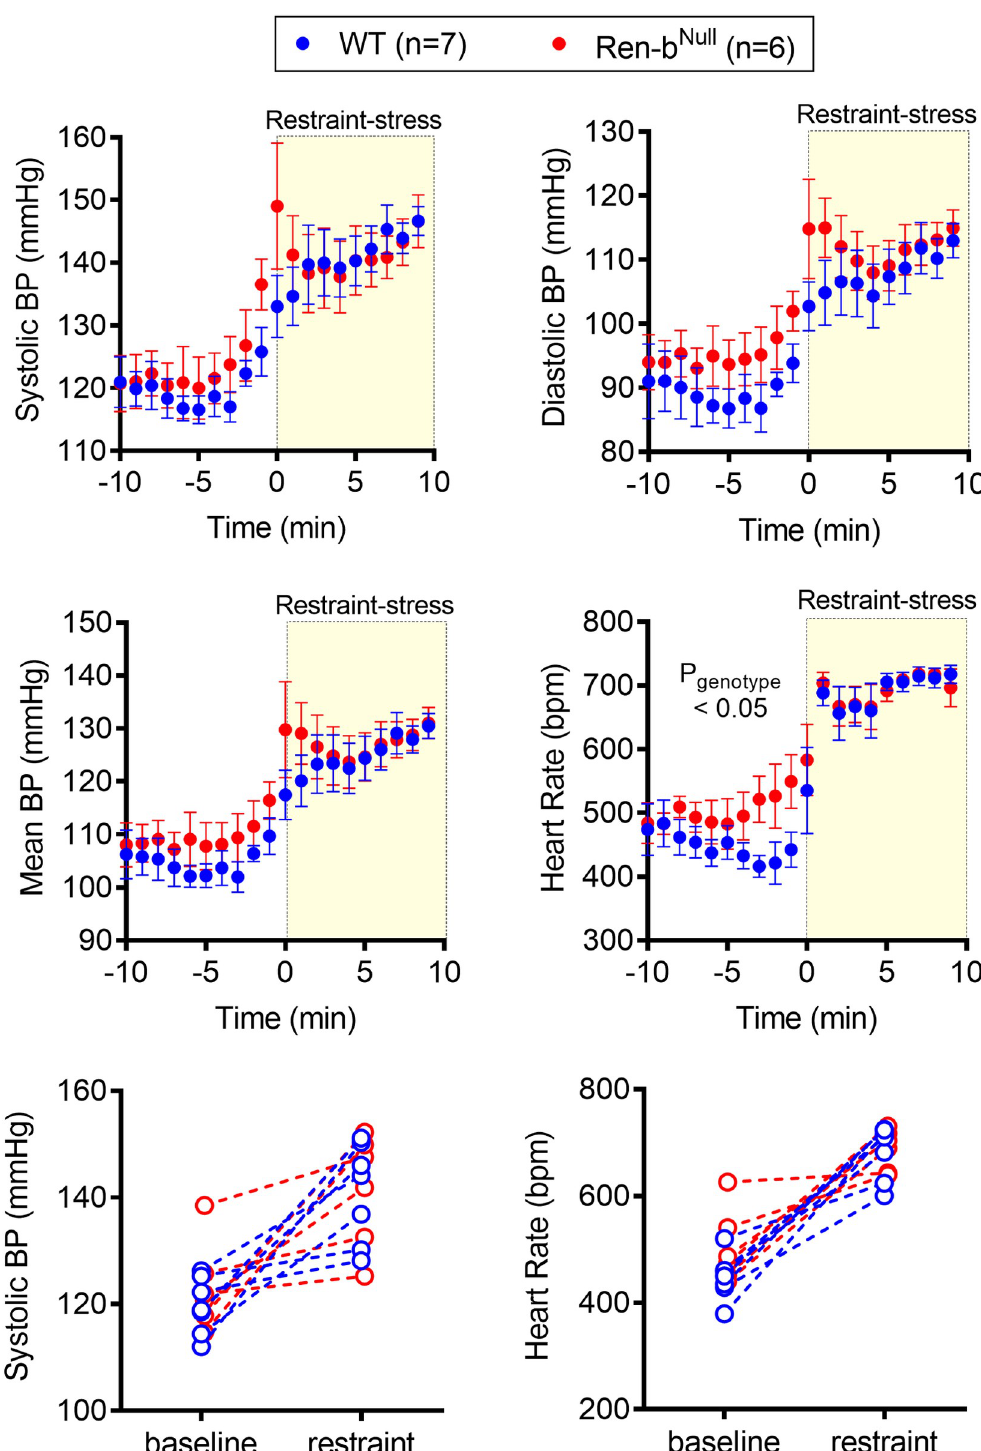
Fig 5. Blood pressure response to restraint stress (HSD). Acute responses to restraint-induced blood pressure (BP) and tachycardia in male Ren-b Null mice and wildtype littermate controls (WT) fed high salt diet. First, telemetric recordings were obtained from high salt diet-fed mice in their home cages at baseline. Following 10 minutes of recording, mice were immediately inserted into an acrylic restrainer and telemetric data were acquired for 10 minutes. One-minute recording was averaged, and the systolic BP, diastolic BP, mean BP, and heart rate (A, B, C, and D, respectively) was expressed as mean